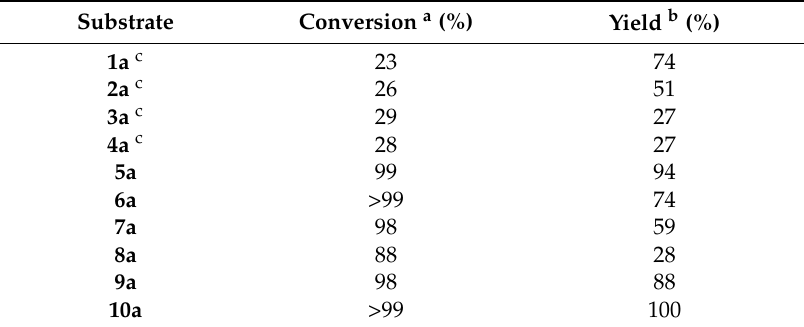
Table 1. Photocatalytic oxidation of various alcohols.